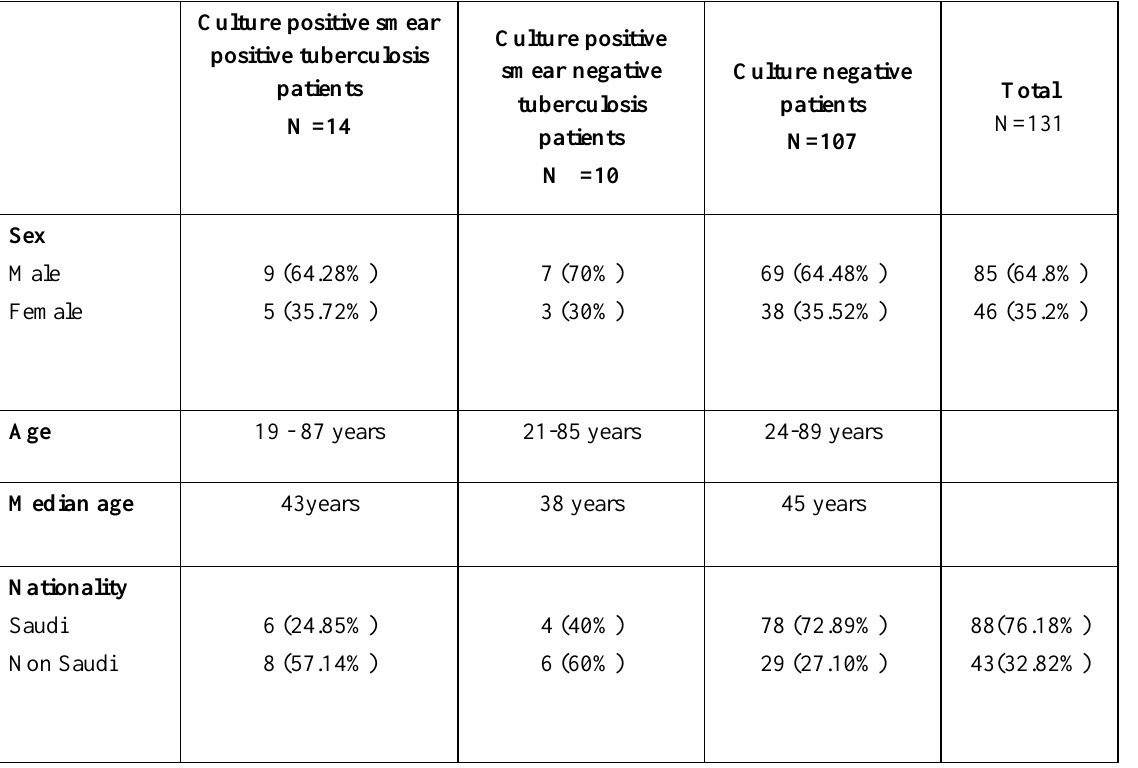
Table 1. Demographic characteristics among studied patients.